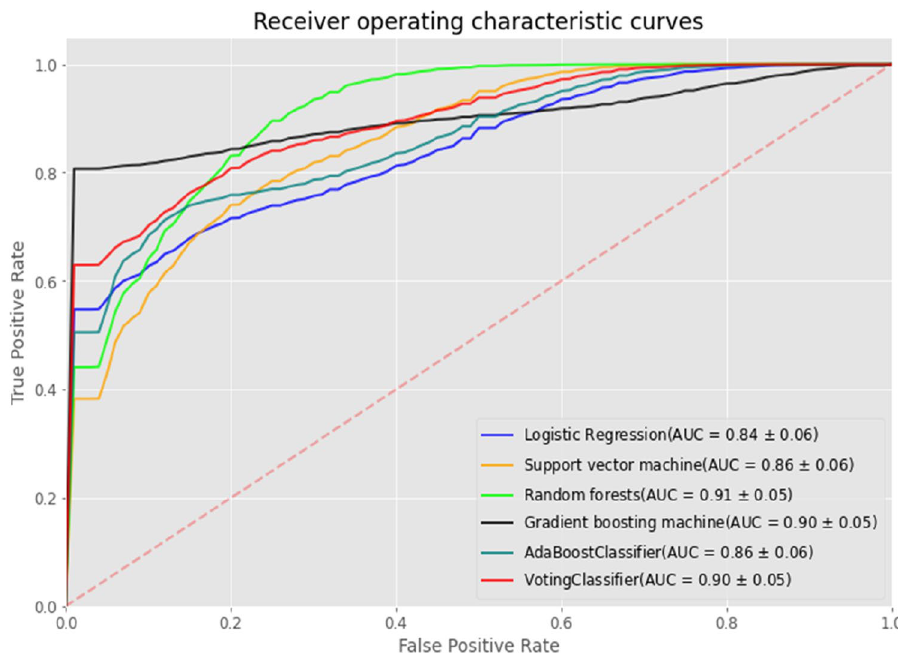
Figure 1. ROC curves for the six ML models on the test data. The AUC value of each model is represented by “(AUC = mean ± standard deviation)”, which was estimated from 1000 bootstrap resamples of predictions on the test data. Each ROC curve is visualized by corresponding plot with shaded bands.